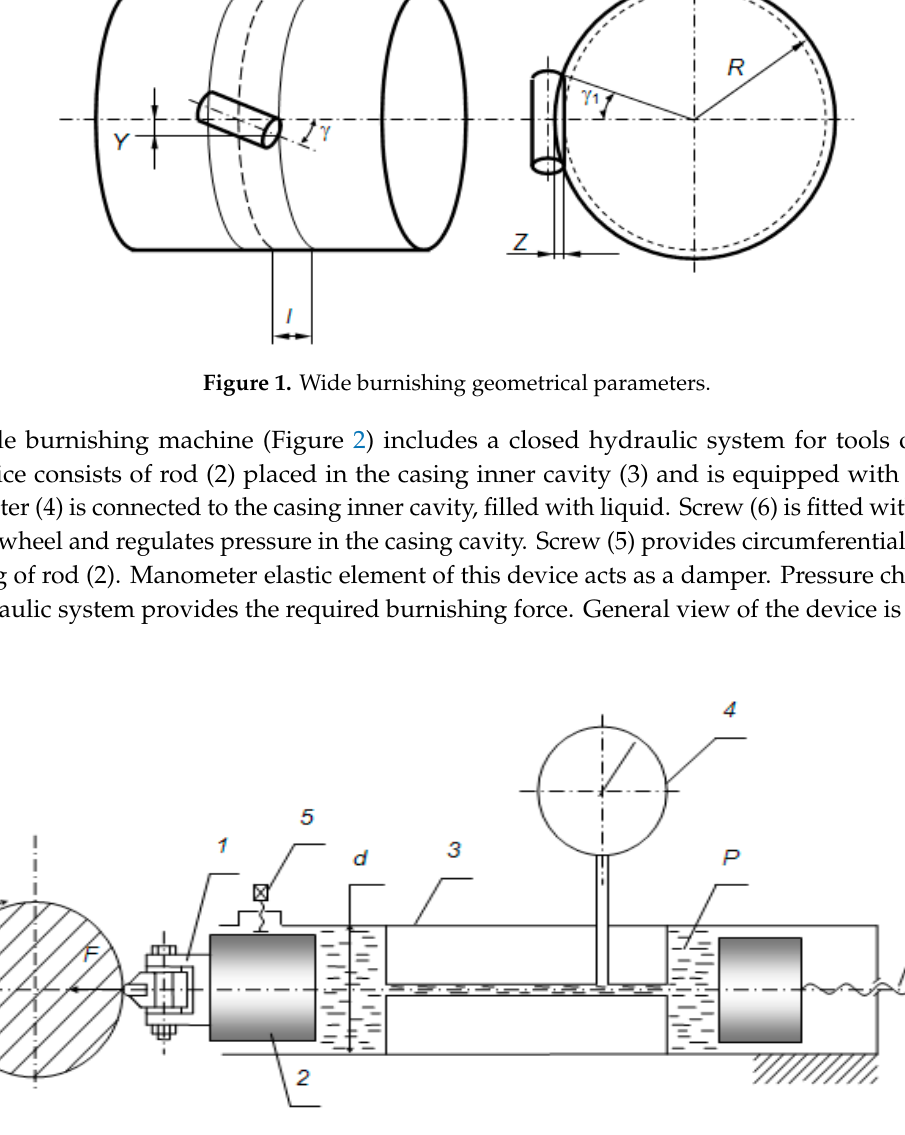
Figure 2. General view of the WB device.